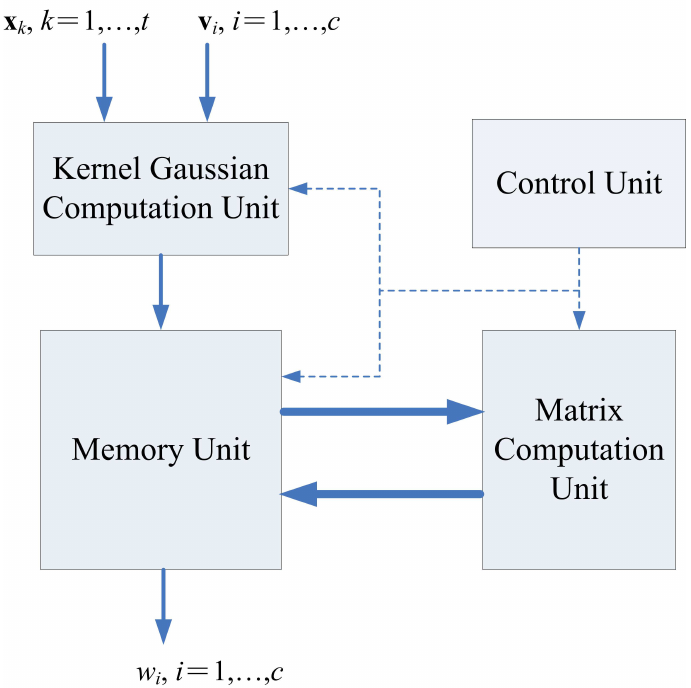
Figure 8. The proposed recursive LMS